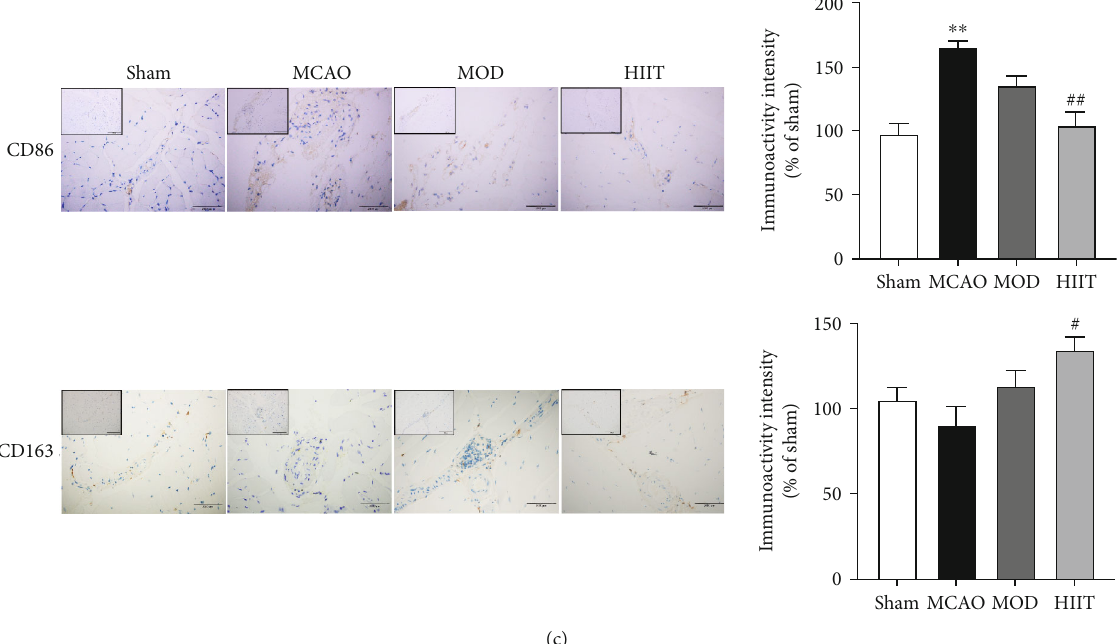
Figure 9: HIIT modulated macrophage-mediated in fl ammation and cytotoxic properties via inhibiting the TLR4/MyD88/NF κ B signaling pathway. (a, b) Representative immunoblots and quanti fi cation normalized to sham group condition of CD86, CD163, TLR4, MyD88, NF κ B, p-NF κ B, and β -actin protein level ( n = 5 ). (c) Representative immunostaining and quanti fi cation of CD86 and CD163 in paretic gastrocnemius tissues ( n = 5 ). Values are expressed as the mean ± SEM of the mean. ∗ P < 0 : 05 and ∗∗ P < 0 : 01 compared with the sham group; # P < 0 : 05 and ## P < 0 : 01 compared with the MCAO group; + P < 0 : 05 and ++ P < 0 : 01 compared with the MOD group as determined by one-way ANOVA (Tukey ’ s multiple comparison test) for the data with normal distribution. The letters for no signi fi cance were not